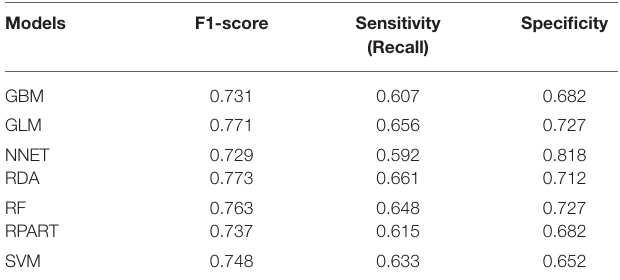
TABLE 5 | Comparison of prediction performance of different models to